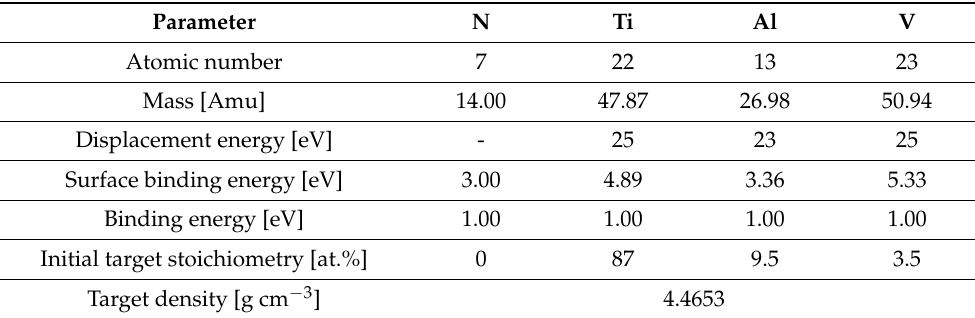
Table 2. DTRIM simulation